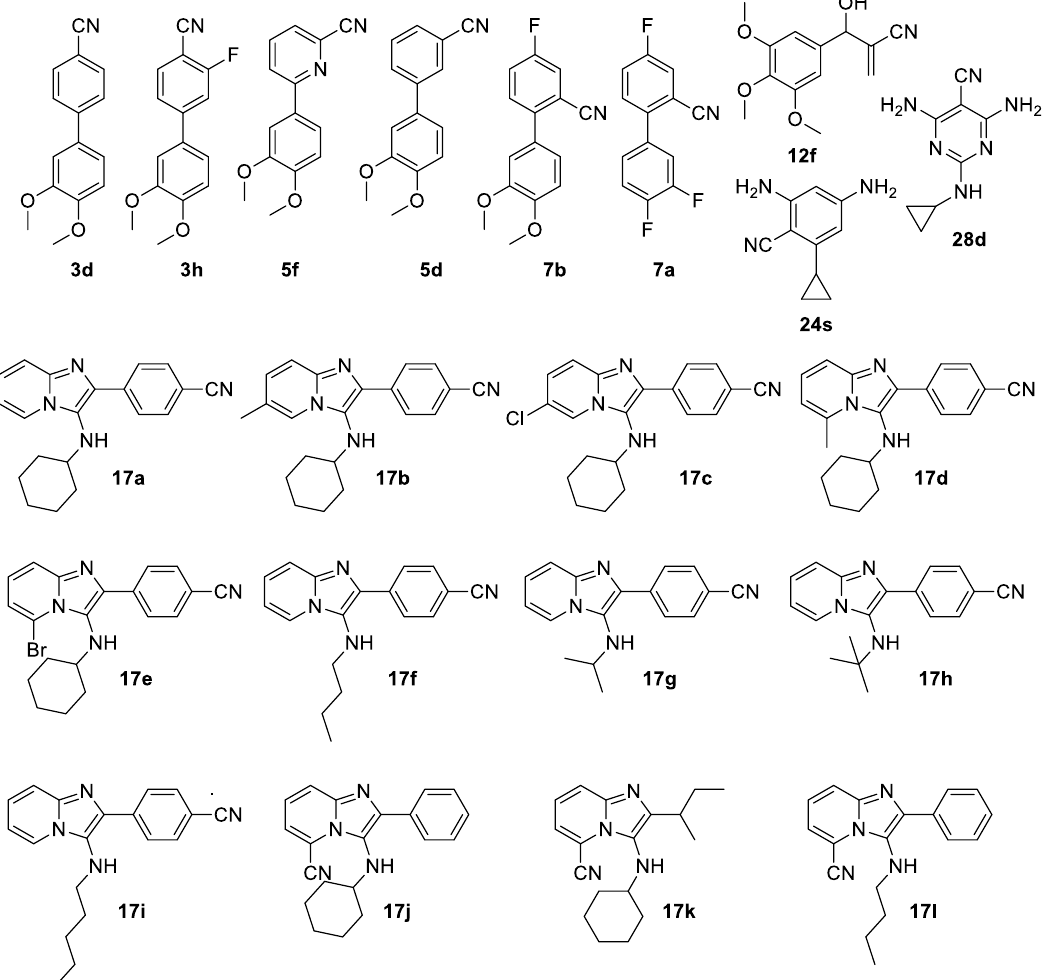
Figure 4. Compounds showing 0% to 5%